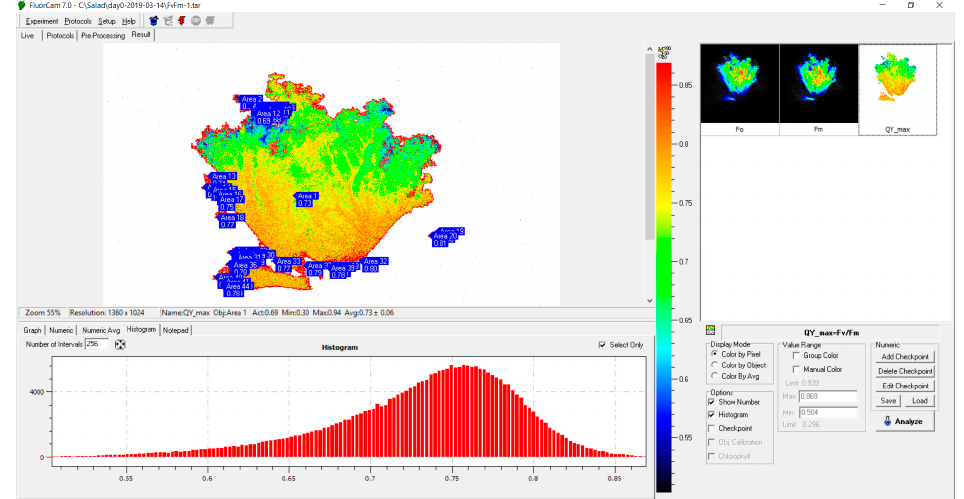
Figure 1. A representative measurement of the spatial distribution of Qy over the lettuce leaf surface with the imaging PAM fluorometer Fluorcam 800. For each image containing the Qy values as pixel values, a histogram was generated and exported for further analysis in Excel spreadsheet software (Microsoft, Redmond, WA, USA). The histograms were then re-binned (i.e., integrated within the selected intervals, see